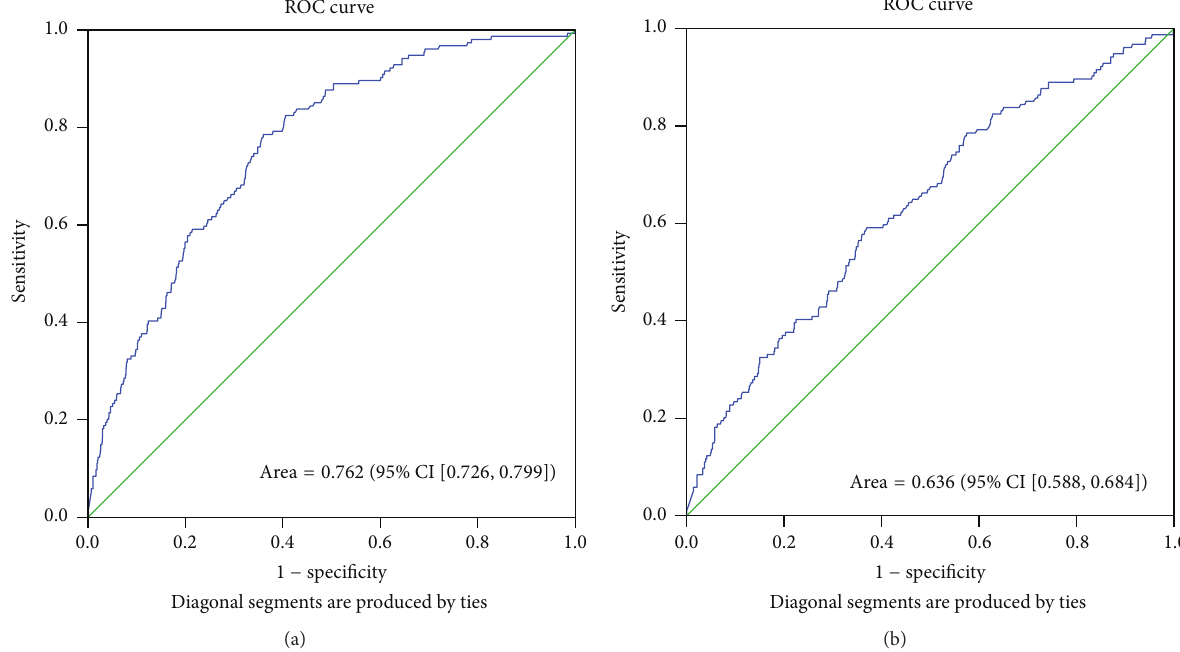
Figure 3: ROC curves for the diagnosis of multiple allergens in (a) patients with an unknown allergic status (AUC = 0.762 (95% CI = 0.726– 0.799), 𝑝 < 0.001 ) and (b) patients already known as allergic for one allergen (AUC = 0.636 (95% CI = 0.588–0.684), 𝑝 < 0.001 ).